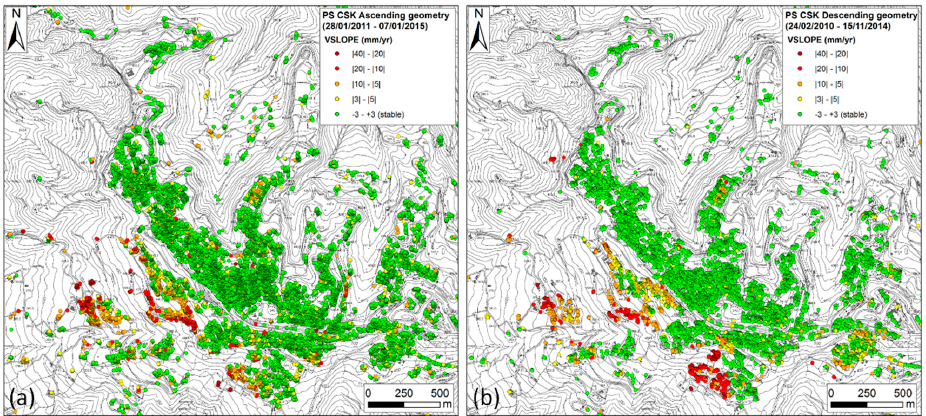
Figure 5. Persistent Scatterers (PS) CosmoSky-Med (CSK) data over Volterra area overlapped on a topographical map: ( a ) Spatial distribution of PS data classified by absolute values of V SLOPE velocity in ascending geometry; ( b ) Spatial distribution of PS data classified by absolute values of V SLOPE velocity in descending geometry.